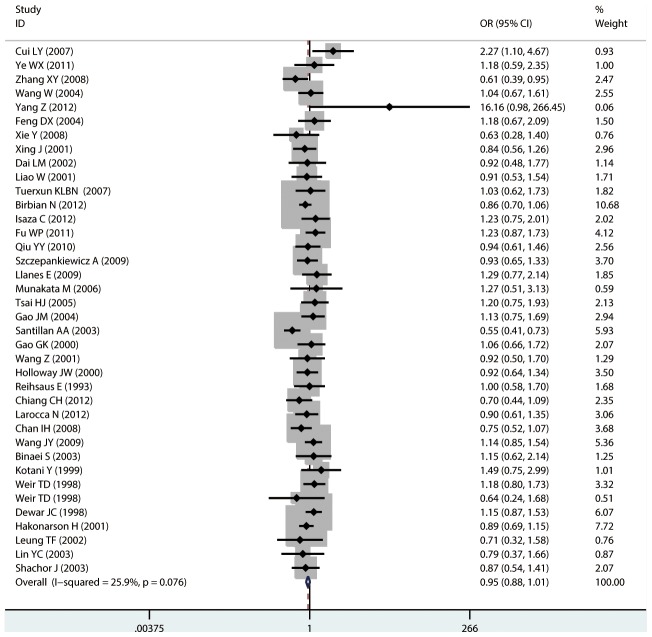
Forest plots of the association between the Gln27Glu (rs1042714) polymorphism and risk of asthma in allele comparison.